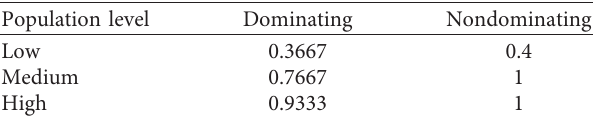
Figure 18: Simulation results for different numbers of neutral agents. Table 5: Bernoulli distribution parameter for different number of neutral